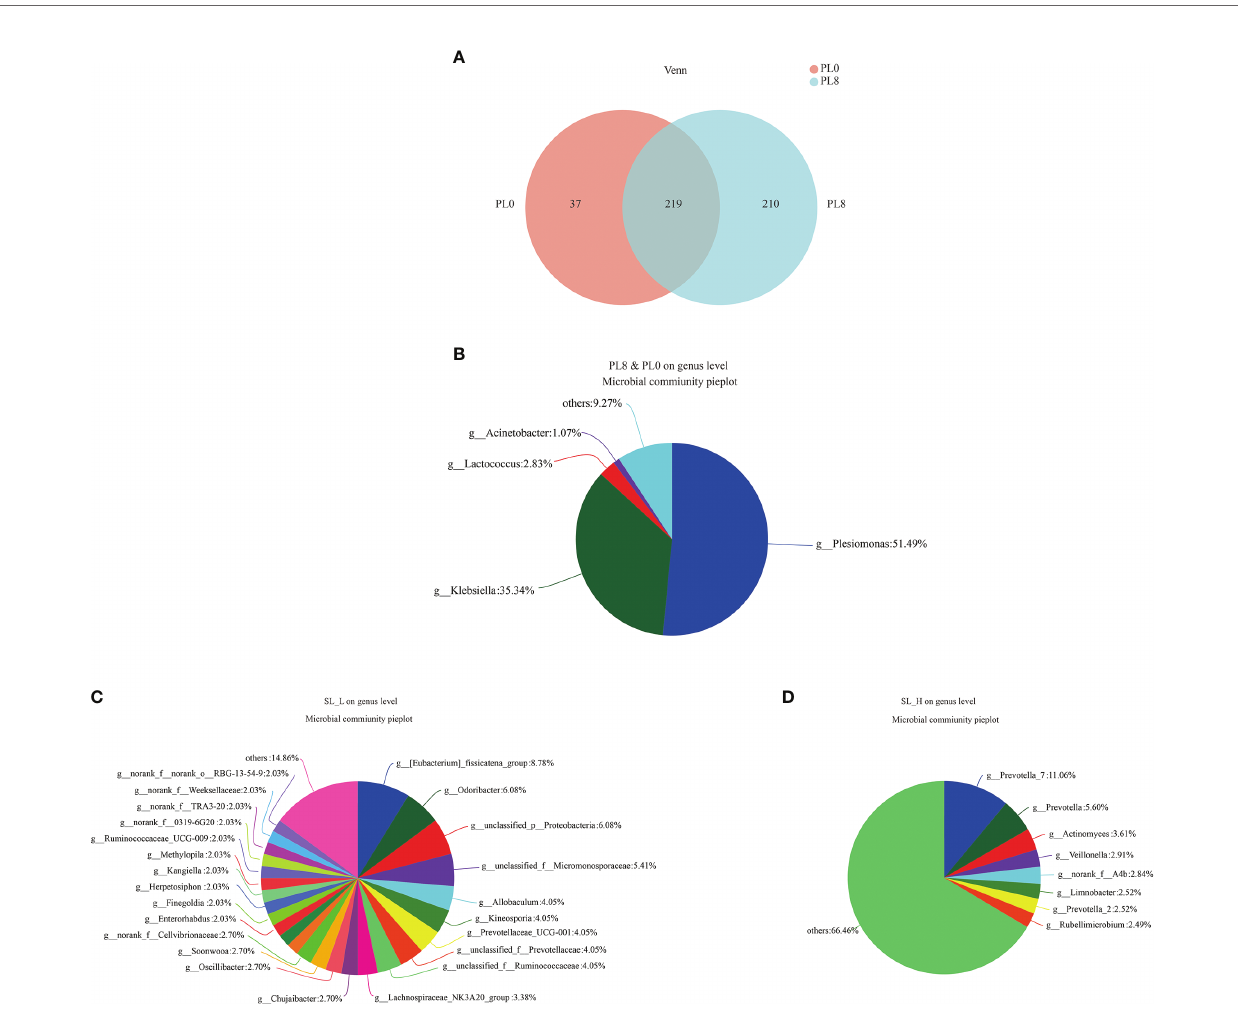
FIGURE 9 | Venn diagram analysis of microbial communities in the intestine of largemouth bass in the PL0 (control) and PL8 groups. The number (A) and community (B ‐ D) of overlapping and unique bacterial genera (C, D) in the intestine of largemouth bass were identi fi